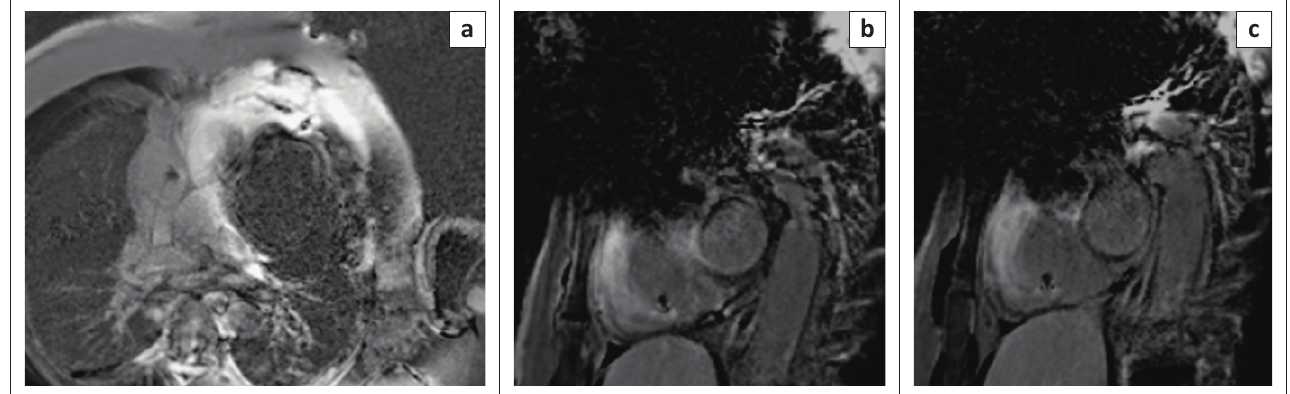
FIGURE 3: Standard LGE sequence (a, b and c). There is central dark signal artifact from the generator with peripheral high signal intensity artifact affecting the